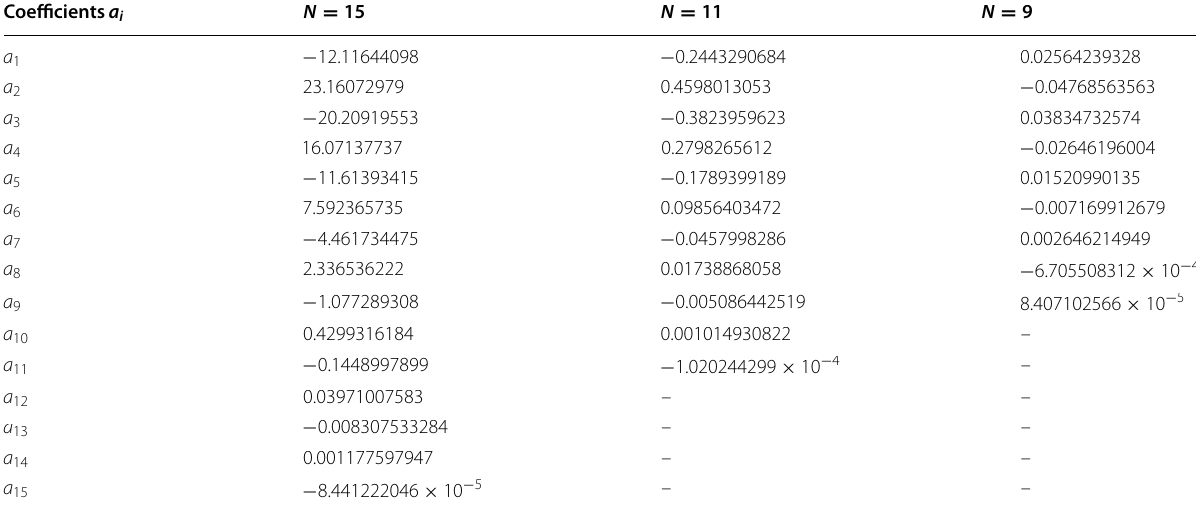
Table 12 Coefficients a i for various N of Rayleigh–Ritz procedure in case (4)